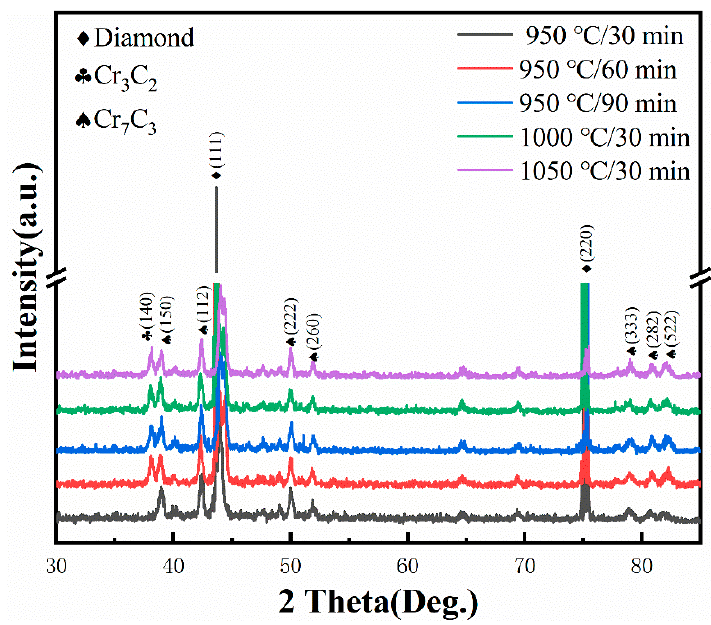
Figure 2. XRD patterns of diamond particles coated at 950–1050